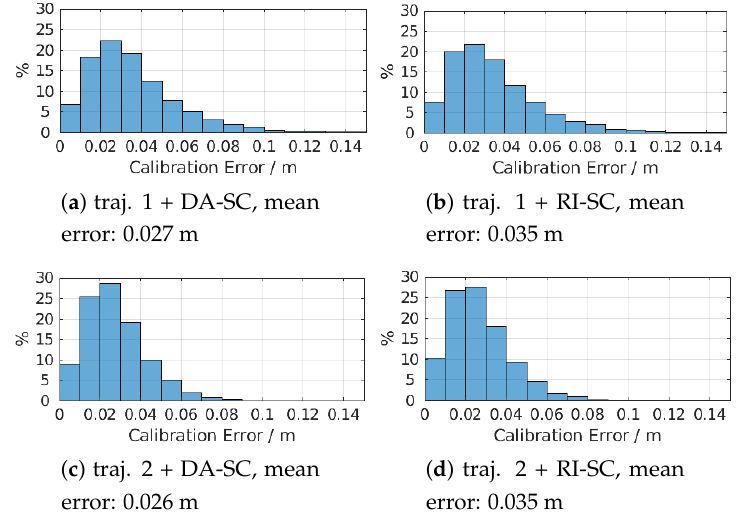
Figure 15. Error distributions for different simulation